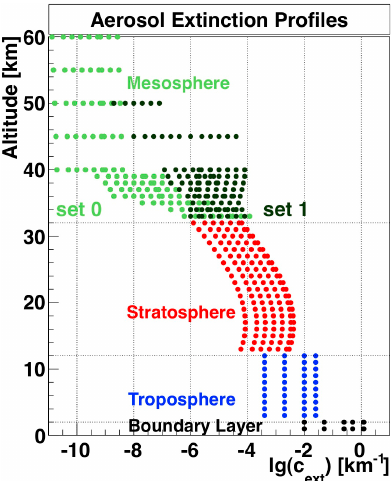
Fig. B1. Aerosols extinction coefficient profiles used in the SCI- ATRAN simulations. The volume extinction coefficient is given at 550nm.